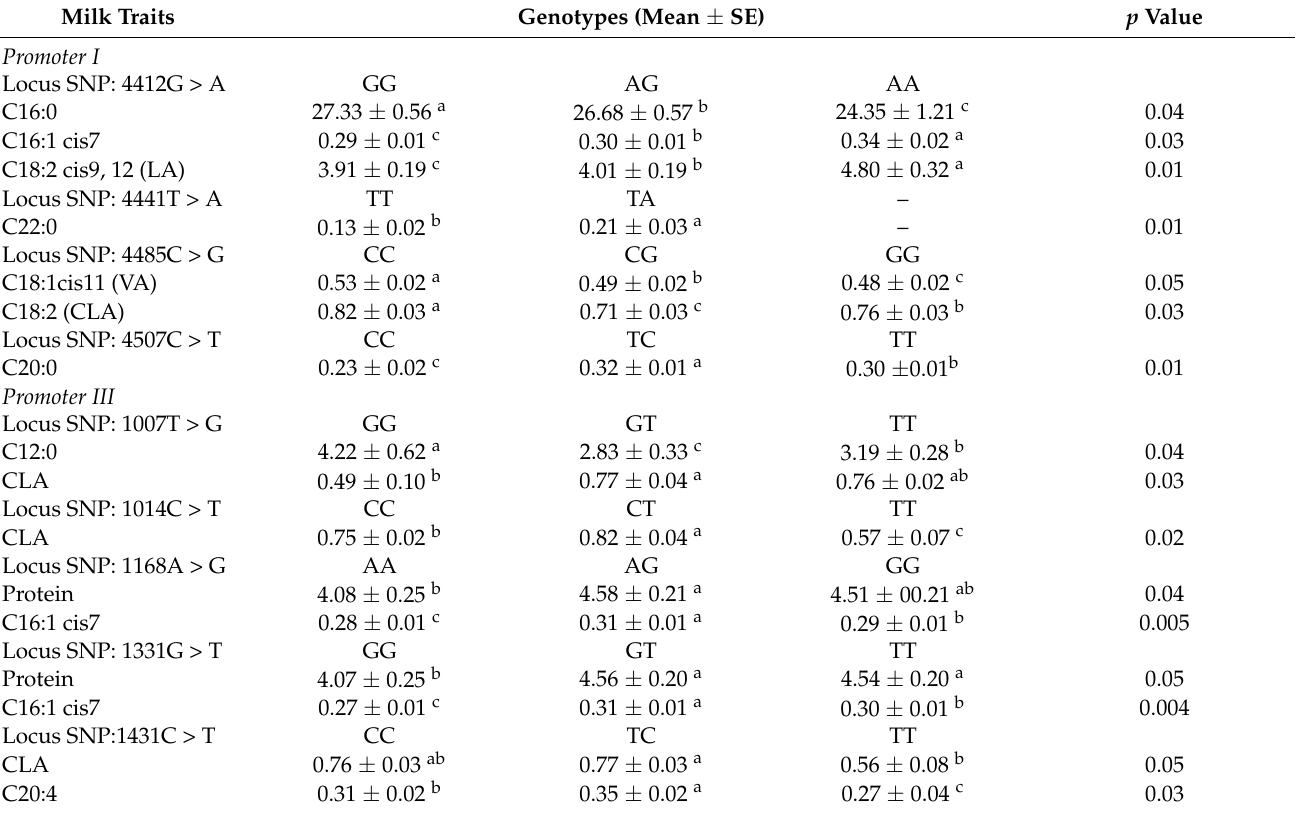
Table 5. The associations of the SNPs of PI and PIII in the ACAC α gene with the milk composition (%) and fatty acid profiles (g/100 g) in Najdi sheep milk. Genotypes (Mean ± SE) p